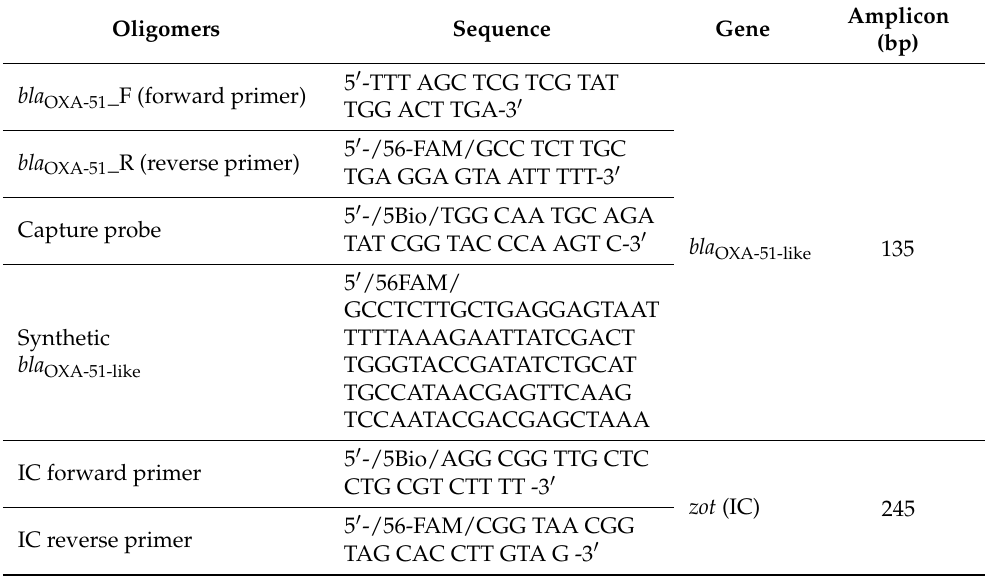
Table 3. Details of oligomers used in this